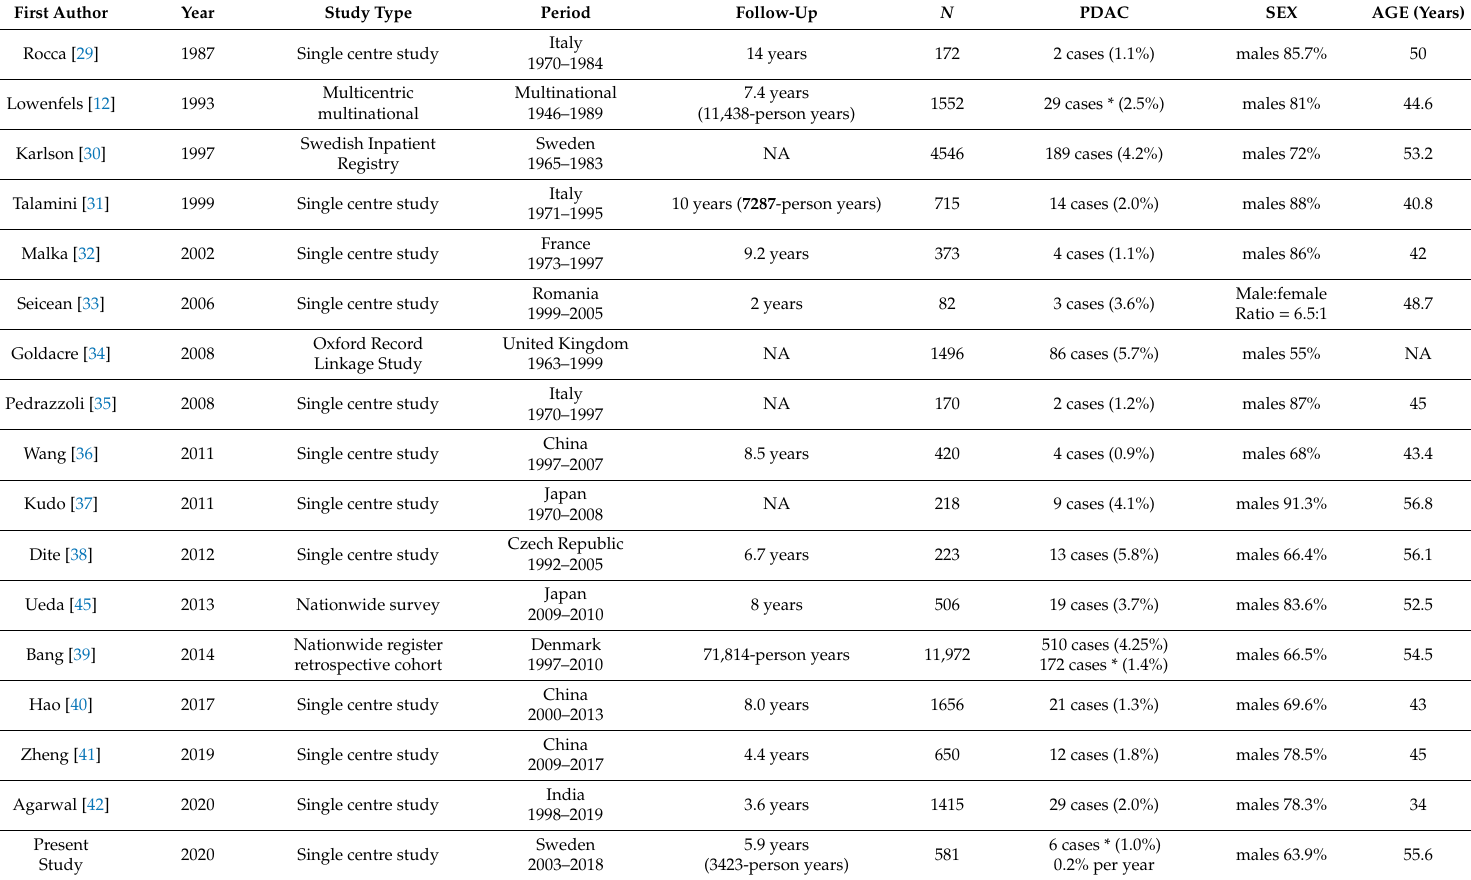
Table 4. Cumulative incidence of pancreatic cancer in cohorts of patients with chronic